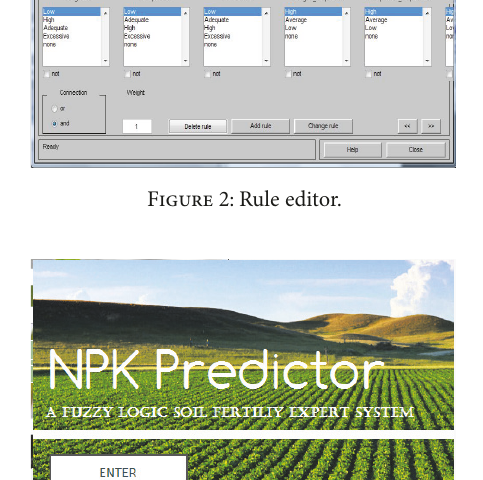
Figure 5: Reading dialog interface showing the result of a user’s input in Figure